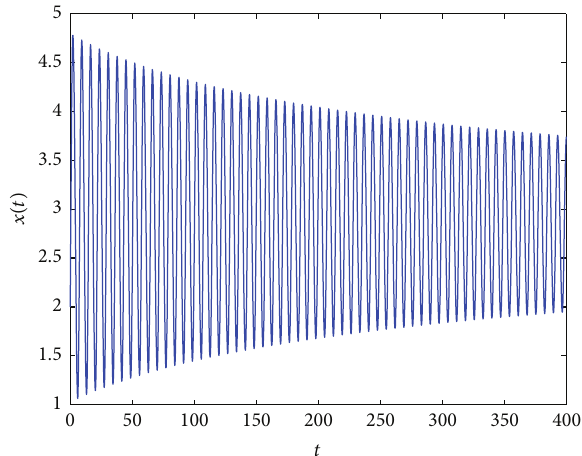
Figure 3: 𝜏 1 = 0 , 𝜏 2 = 0.7273 , periodic solution bifurcates from (𝑝 ∗ ,0)